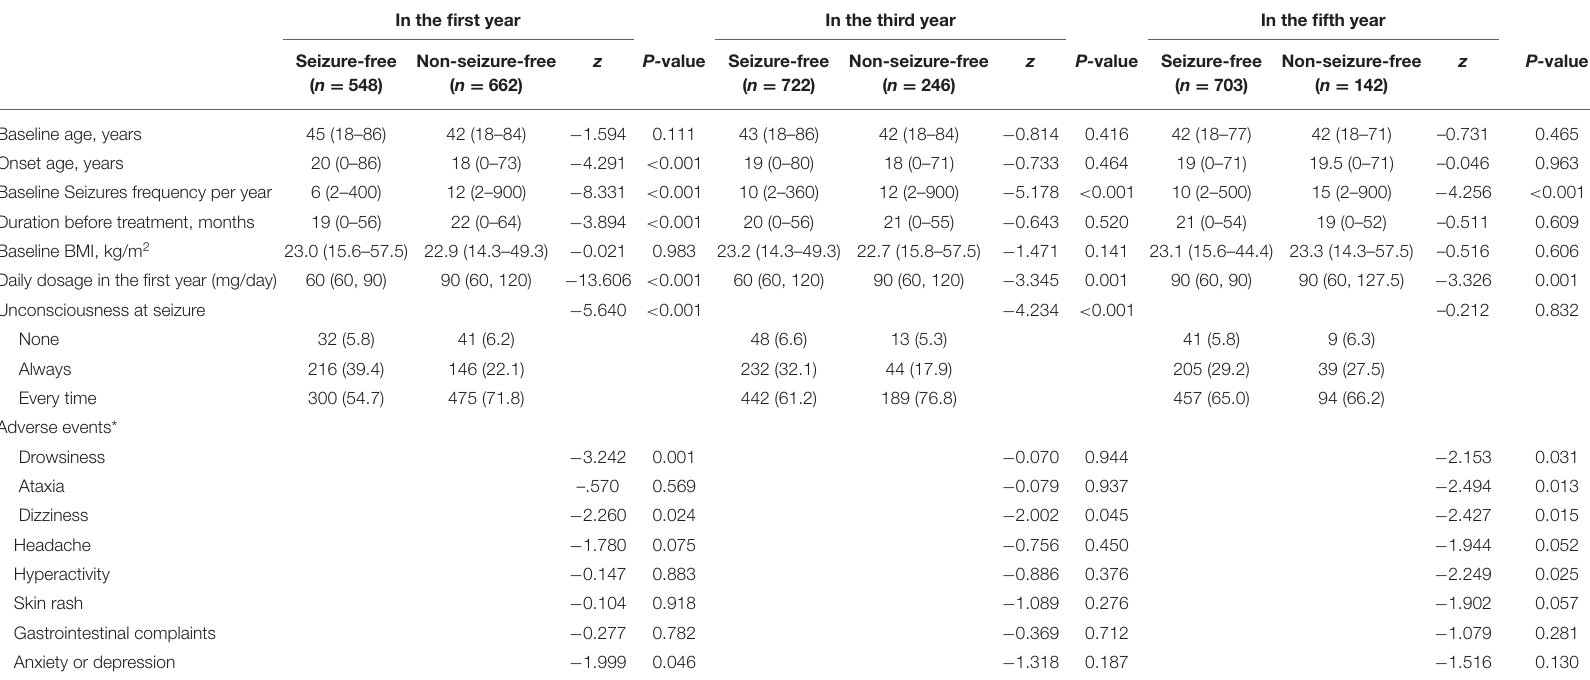
TABLE 3 | Comparison of baseline characteristics, medication and adverse events between different prognosis, N (%) or median